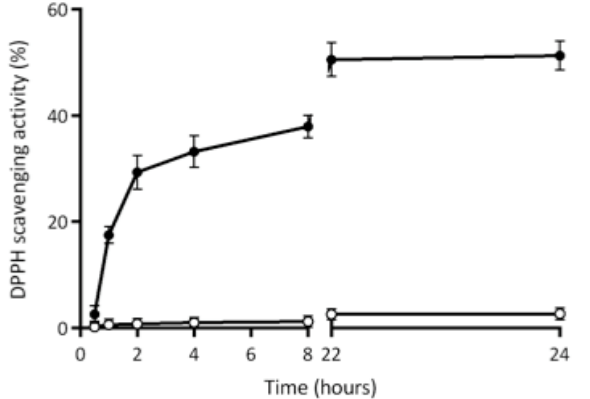
Figure 10. Profile of antioxidant agent release during 24 h in the 2,2-diphenyl-1-picrylhydrazyl (DPPH) solution from the matrix of hemp-protein-based films prepared in the absence (- -) or presence (- • -) of egagropili lignin fraction (6% w / w protein). Further experimental details were given in the text.